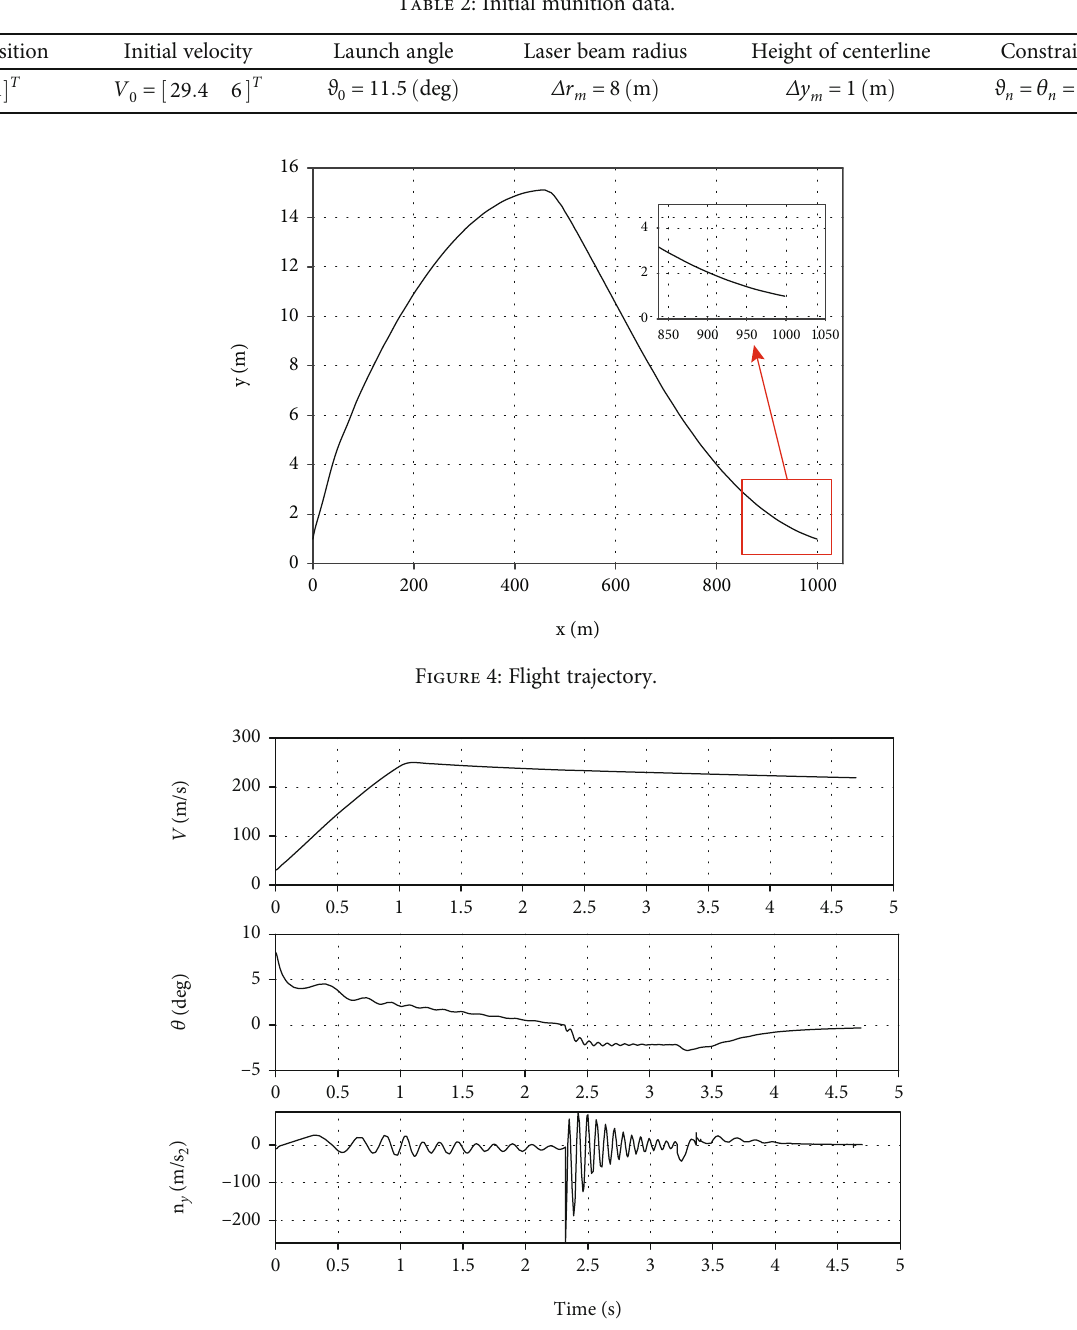
Figure 5: Velocity, inclination angle, and